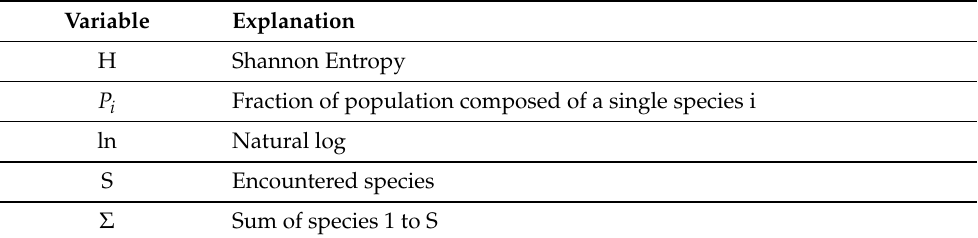
Table 4. Explanation of shannon entropy formula.